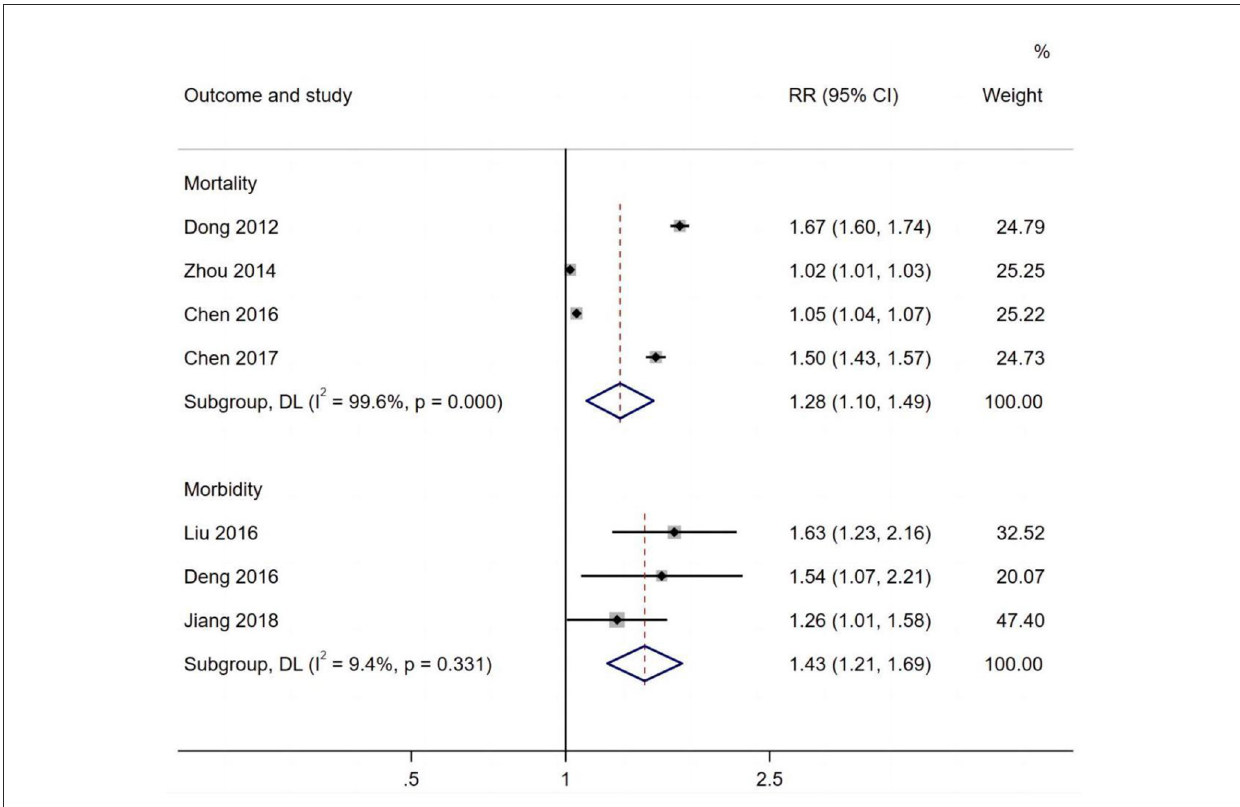
FIGURE5 PM 10 effects on respiratory mortality and